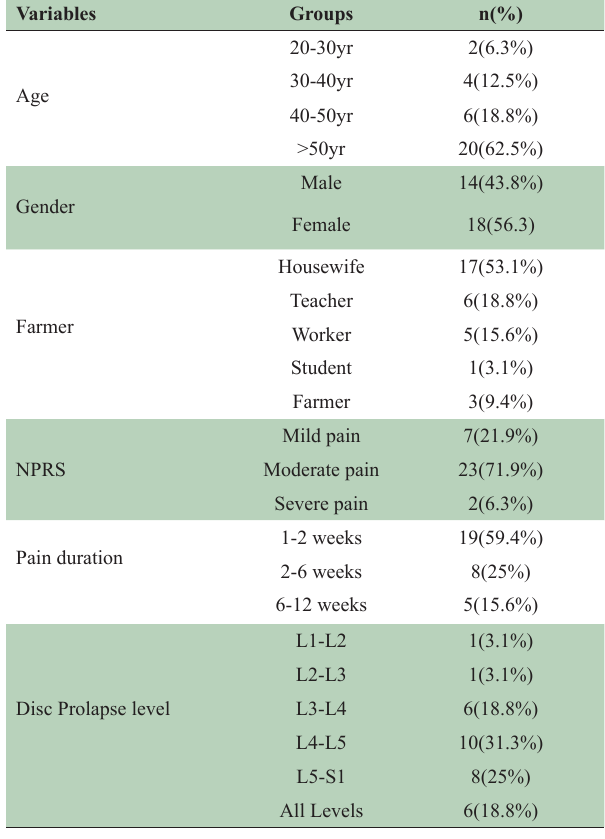
Table-II: Correlation among pain intensity and MRI findings.